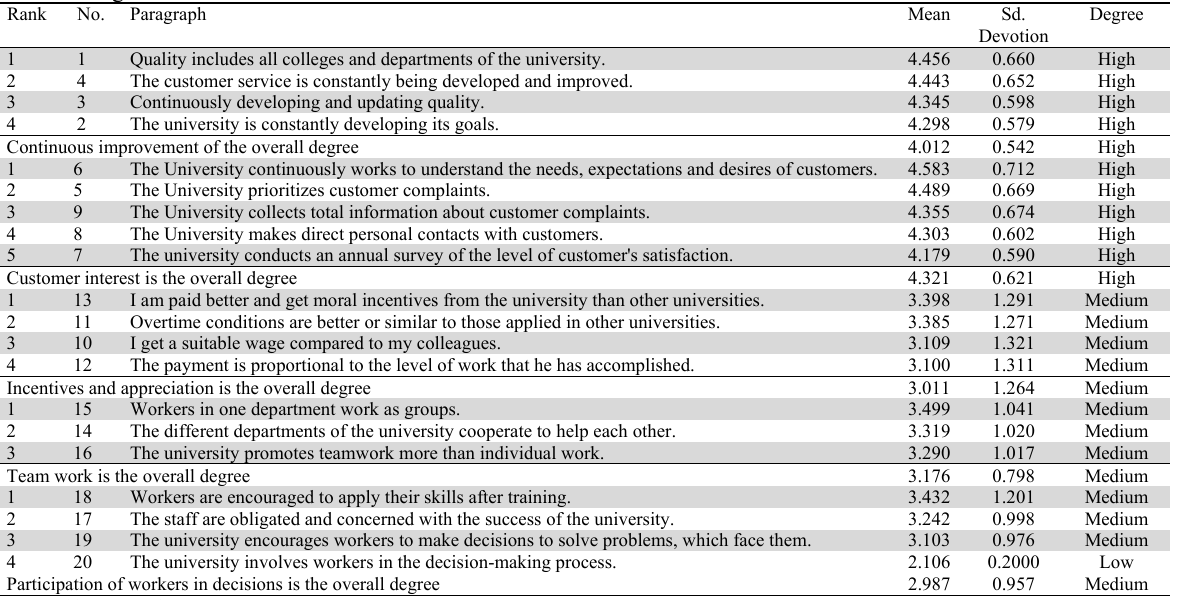
Arithmetic averages and standard deviations of employees' perceptions for each of the principles of total quality management, in descending order